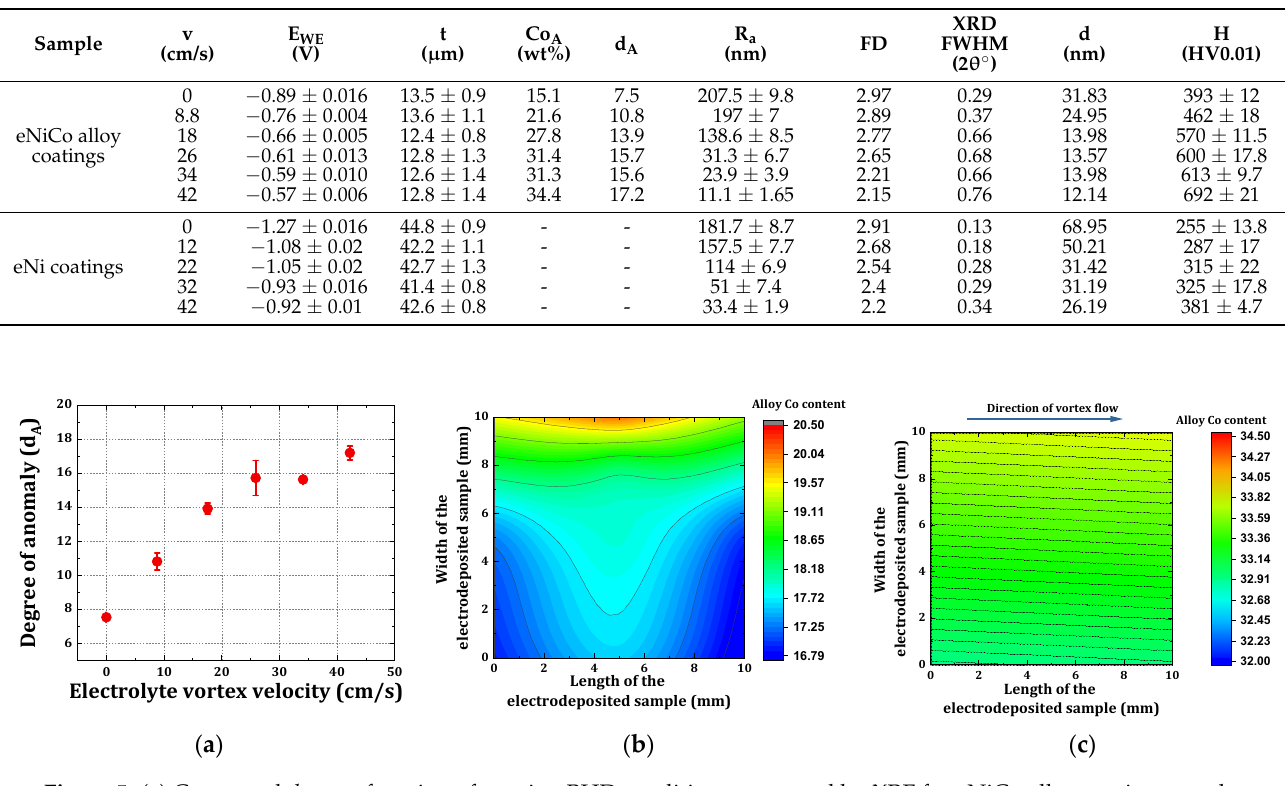
Figure 5. ( a ) Computed d A as a function of varying BHD conditions measured by XRF for eNiCo alloy coating samples electrodeposited at 50 mA/cm 2 , bath pH value 4, 45 °C for 15 min; ( b ) 2D contour plot showing the alloy mapping with the measured Co A content (in wt%) across the coated surface for eNiCo alloy coating sample electrodeposited without BHD; and ( c ) eNiCo alloy coating sample with BHD at v = 42 cm/s. The cathode was placed at x = 40 mm from the vortex core for all depositions.